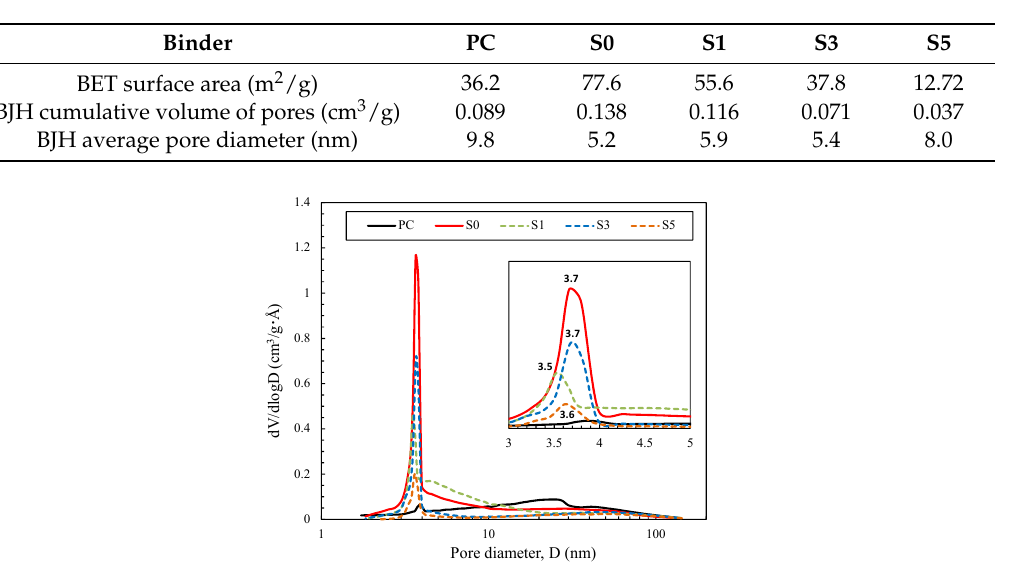
Table 5. Pore characteristics of powdered binders.